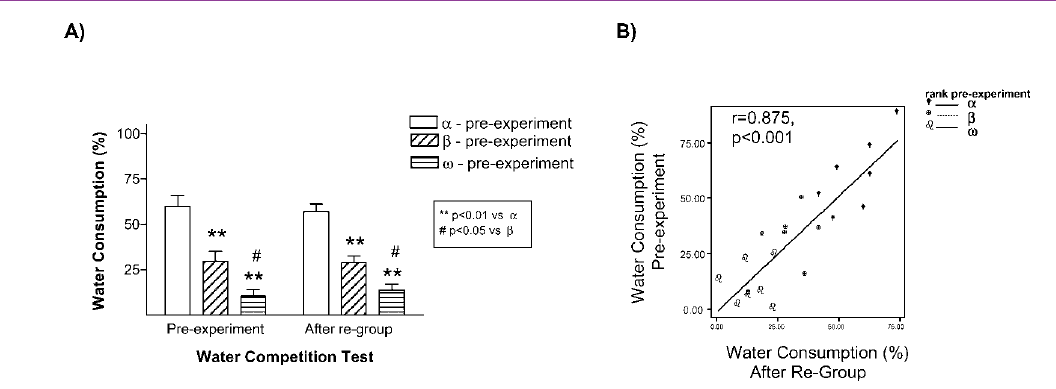
Figure 4. Group-housed rats maintained their previous hierarchy status after being re-housed together once the social memory experiments were finished (day 8). In the left panel the graph represents the water consumption ratio average between group-cage rats during the WCT performed the week before the experiment started (pre-experiment) and when they were re-housed together after the WCT on day 8 (A). Rats with the highest ratio in time dedicated to water consumption during the WCT pre-experiment were identified as alpha (blank bars), those with the lowest ratio as omega (bars with horizontal lines), and the rats in between both types as beta (bars with slant lines). ** p<0.01 vs. α -rats, # p<0.05 vs. β -rats. On the right panel the relationship between the ratio of water consumption during WCT pre-experiment and after re-group is represented (B). Equivalent hierarchy status was observed in homecage-based WCTs delivered before or after the “social memory” experimental